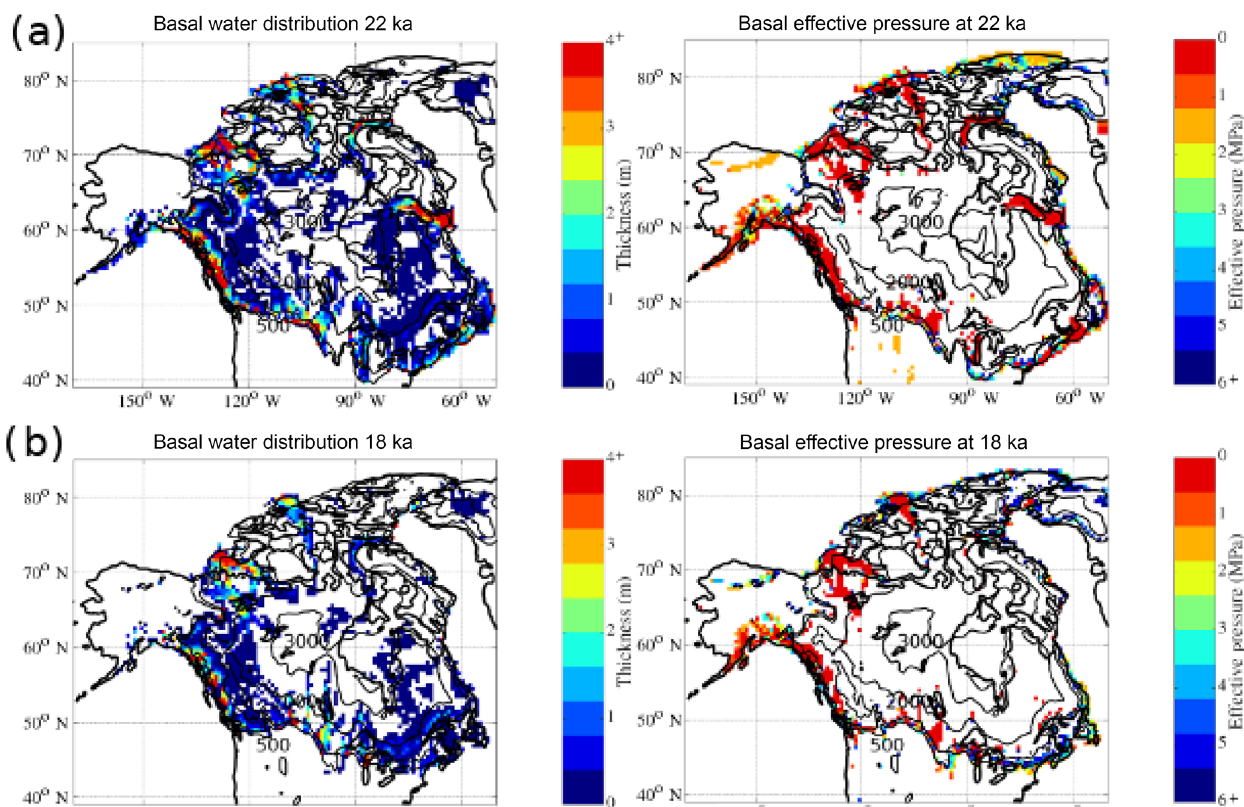
Figure 5. Basal water profiles for (a) 22ka when the total water volume is high (mean thickness: 1 . 0644 ± 2 . 8317m; max thickness: 86.40m), and (b) 18ka, after a large reduction in total basal water volume (mean thickness: 0 . 6918 ± 1 . 3160m; max thickness: 24.91m). Five hundred metre contour intervals for surface elevation are also